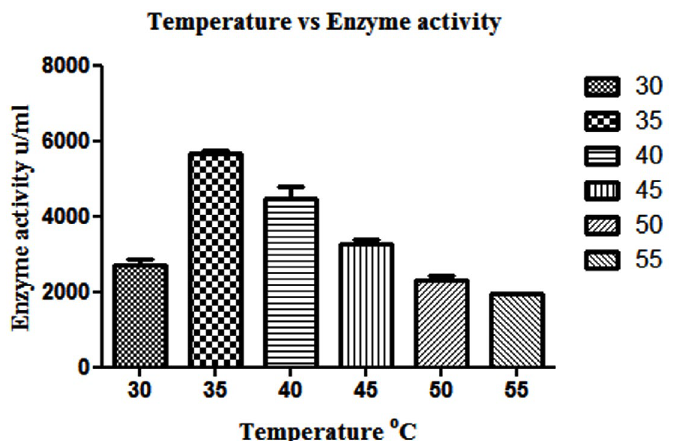
Fig. 2. Effect of different temperature on β-gal production by L. fermentum . Bars show standard deviations with significant difference (p<0.05)